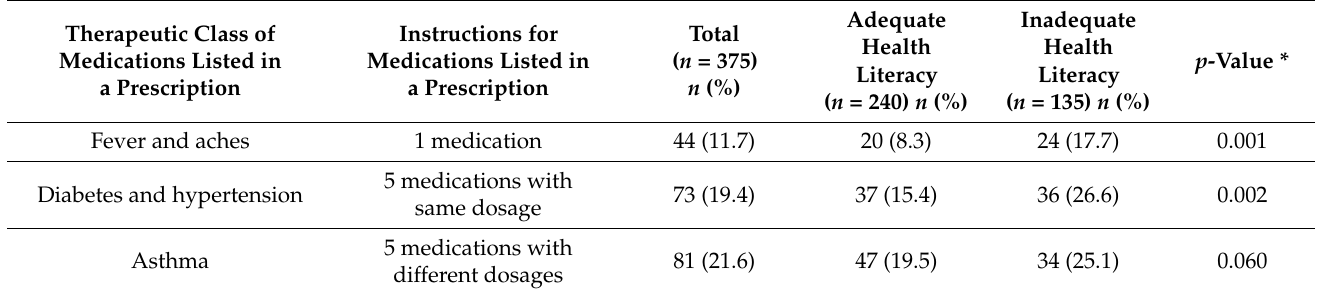
Table 3. Proportion of participants misunderstanding prescription drug instructions by prescription regimen